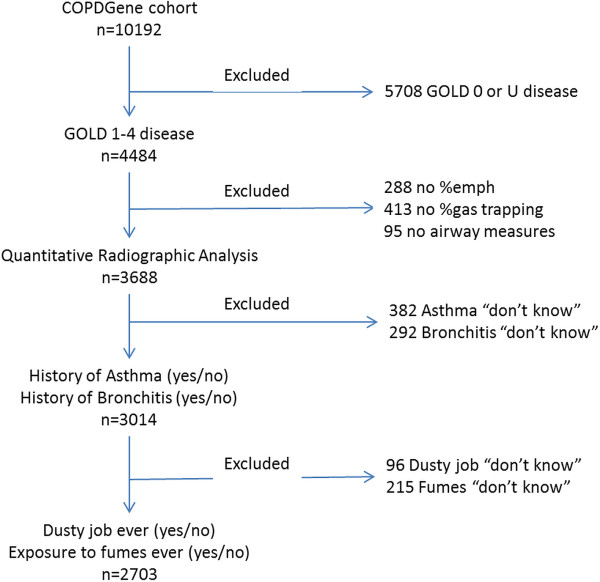
Selection of cohort.